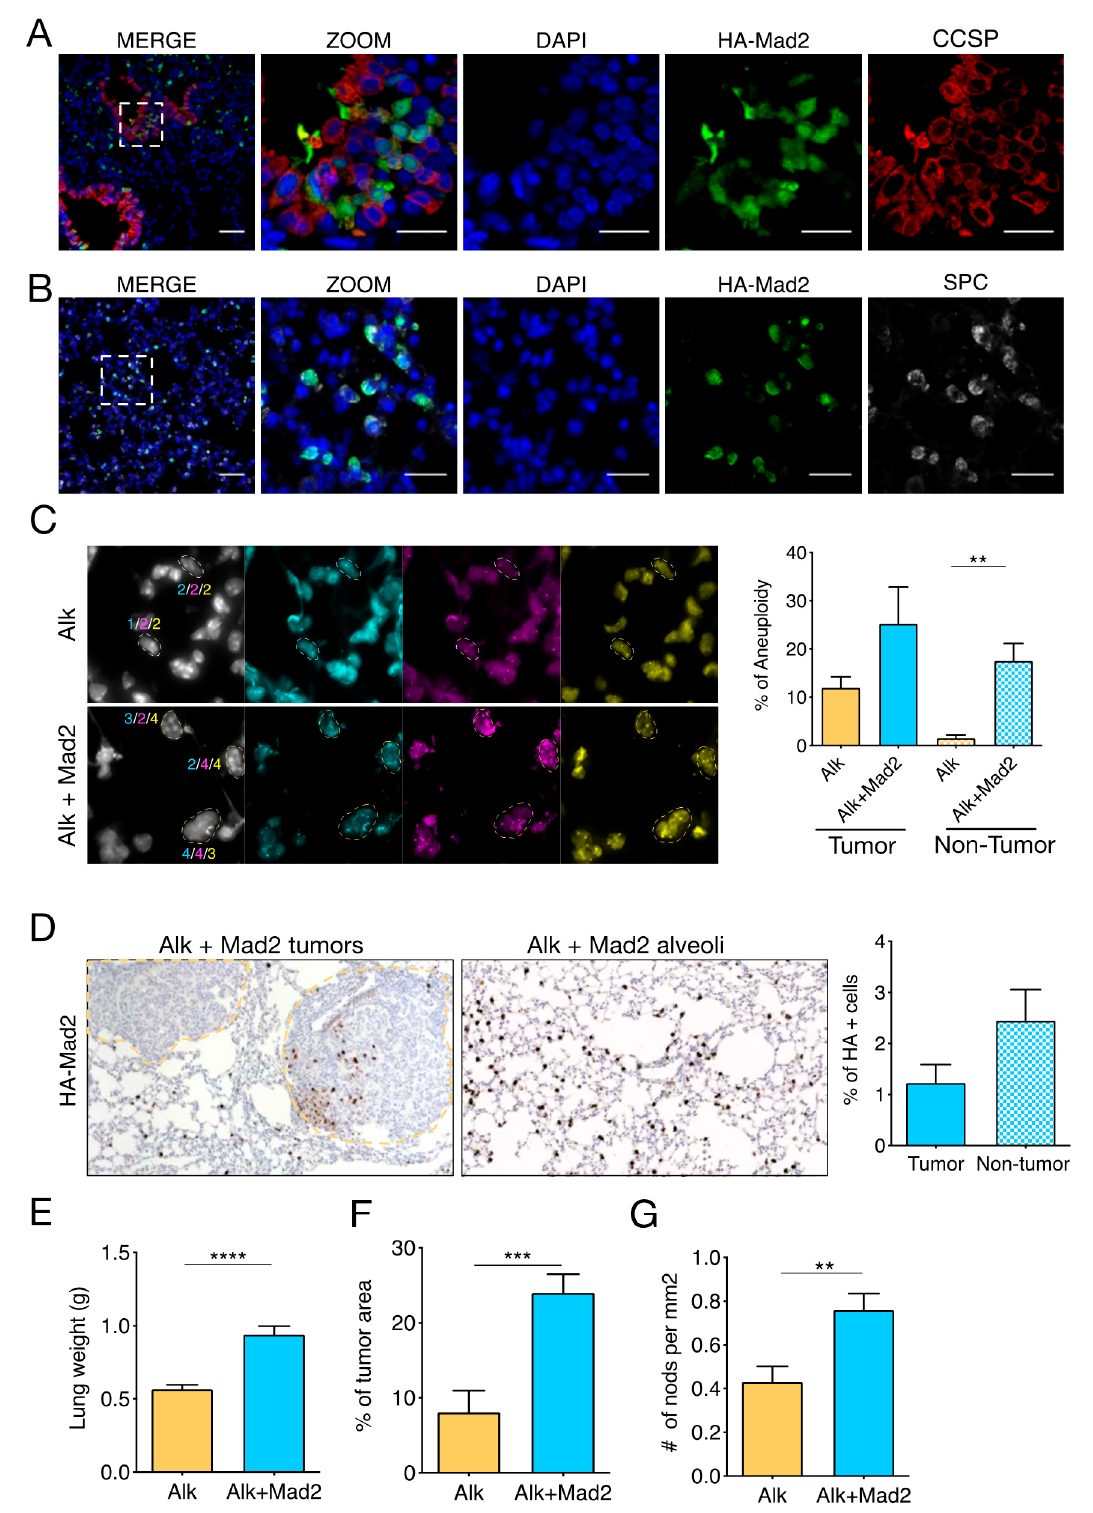
Figure 1. Mad2 overexpression results in increased tumor burden in Eml4-Alk mice. ( A , B ) Immunofluorescence of HA-Mad2 and CCSP ( A ) or HA-Mad2 and SPC ( B ) showing that HA-Mad2 was expressed in Club cells and AT2 cells in the distal